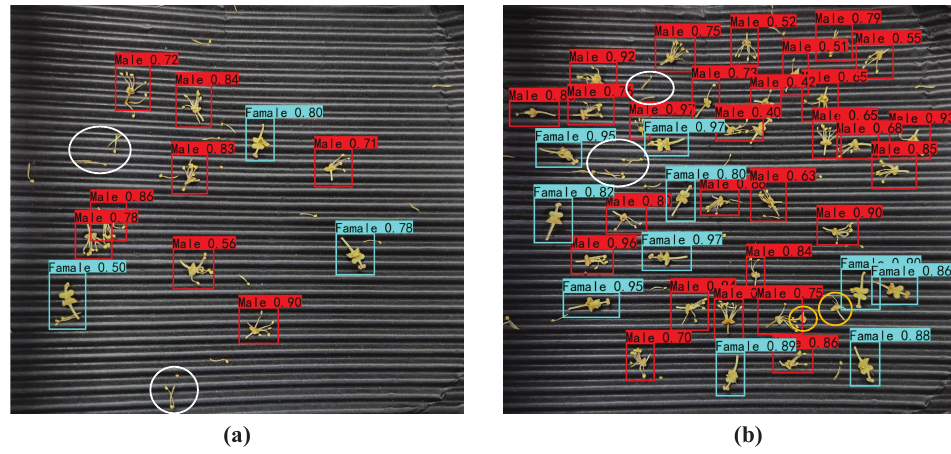
Figure 10. Test results of the model for the detection of male and female litchi flowers after distillation. ( a ) Sparse object. ( b ) Intensive object.